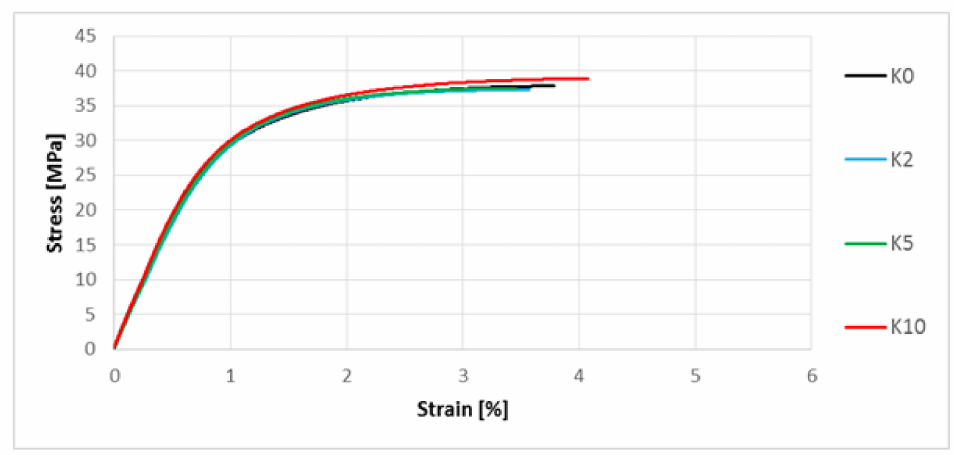
Figure 9. Stress–strain characteristics for composites with unmodified hemp fibers and those modified by 2%, 5% and 10% NaOH solution.